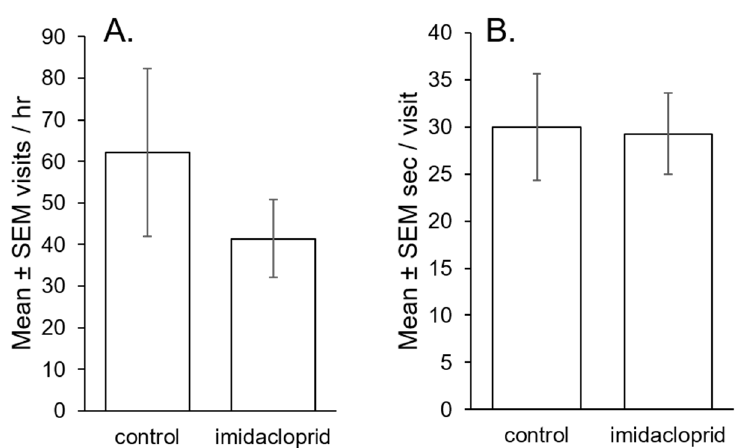
Figure 6. Mean ± SEM flower visits per hour ( A ) and seconds per visit ( B ) by Bombus impatiens bees in mesh field enclosures. Enclosures contained five imidacloprid-treated and five untreated flowering potato plants and a single bee colony of 10–15 foragers. Bees were allowed to forage and were observed for 15 min/enclosure/day.